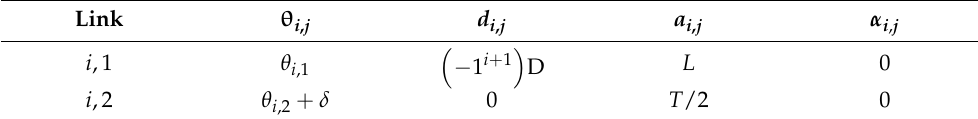
Table 2. D-H parameters of the six-track robot, where i ∈ ( 1,2,3,4,5,6 ) , j ∈ ( 1,2 )